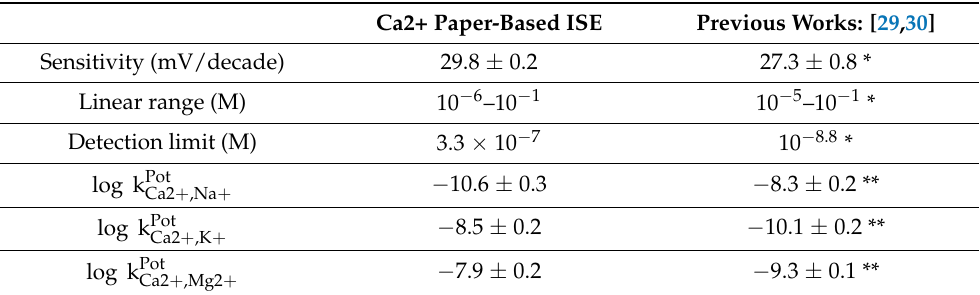
Table 2. Comparison of the analytical parameters of the paper-based Ca-ISE (N =